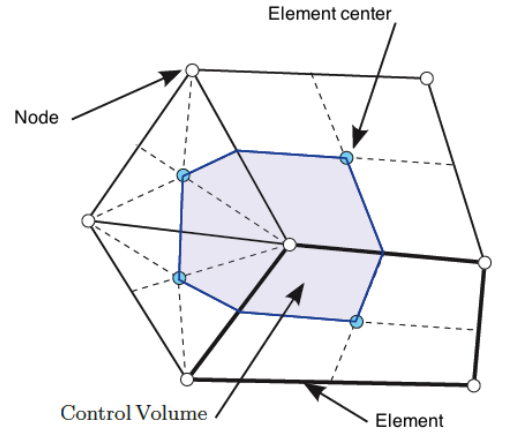
Figure 1. Control volume for 2D